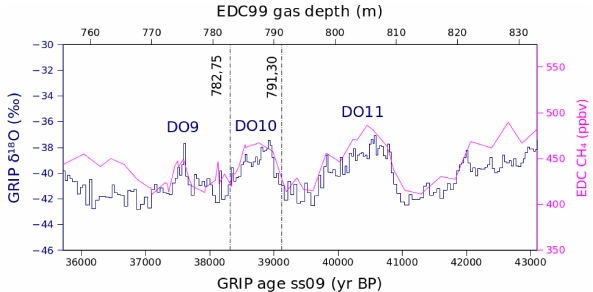
Fig. 4. Synchronisation of GRIP δ 18 O and EDC CH 4 during DO9– 11. The two vertical dashed lines mark the position of the 10 Be sub-peaks in the GRIP core and give the corresponding gas depths in the EDC99 ice core.